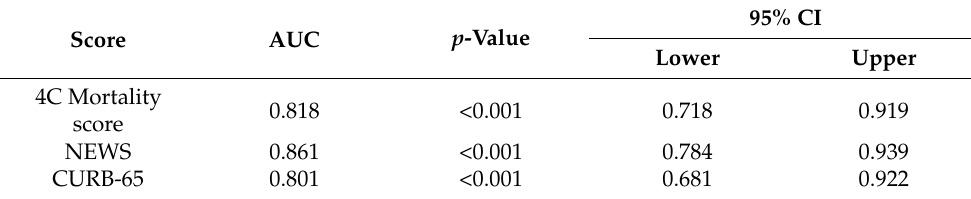
Table 4. Diagnostic accuracy measures for mortality prediction at cut-offs of the 4C Mortality Score, NEWS, and CURB-65. Cut-Off